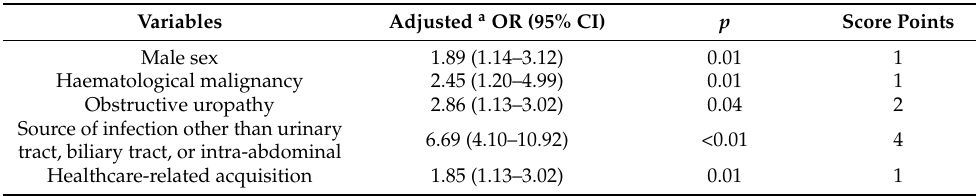
Table 2. Independent risk factors for Pseudomonas spp. bloodstream infection in community-onset patients and assignment of scores based on regression coefficients obtained from multivariate logistic regression analysis. Dates expressed as adjusted OR a (95% CI), p value.